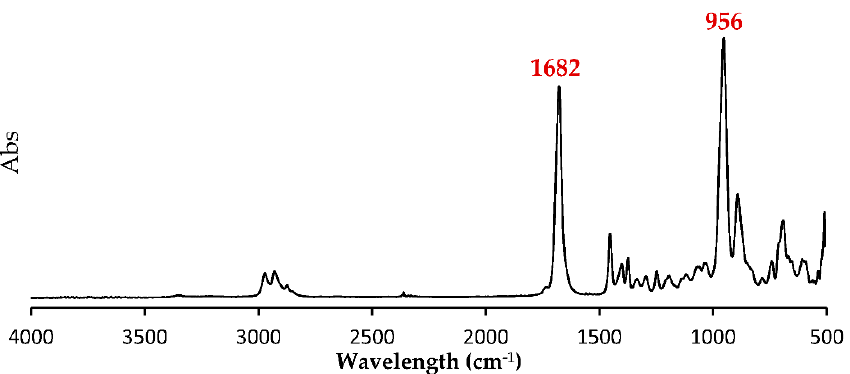
Figure 3. FTIR spectra of P(3M2MP).